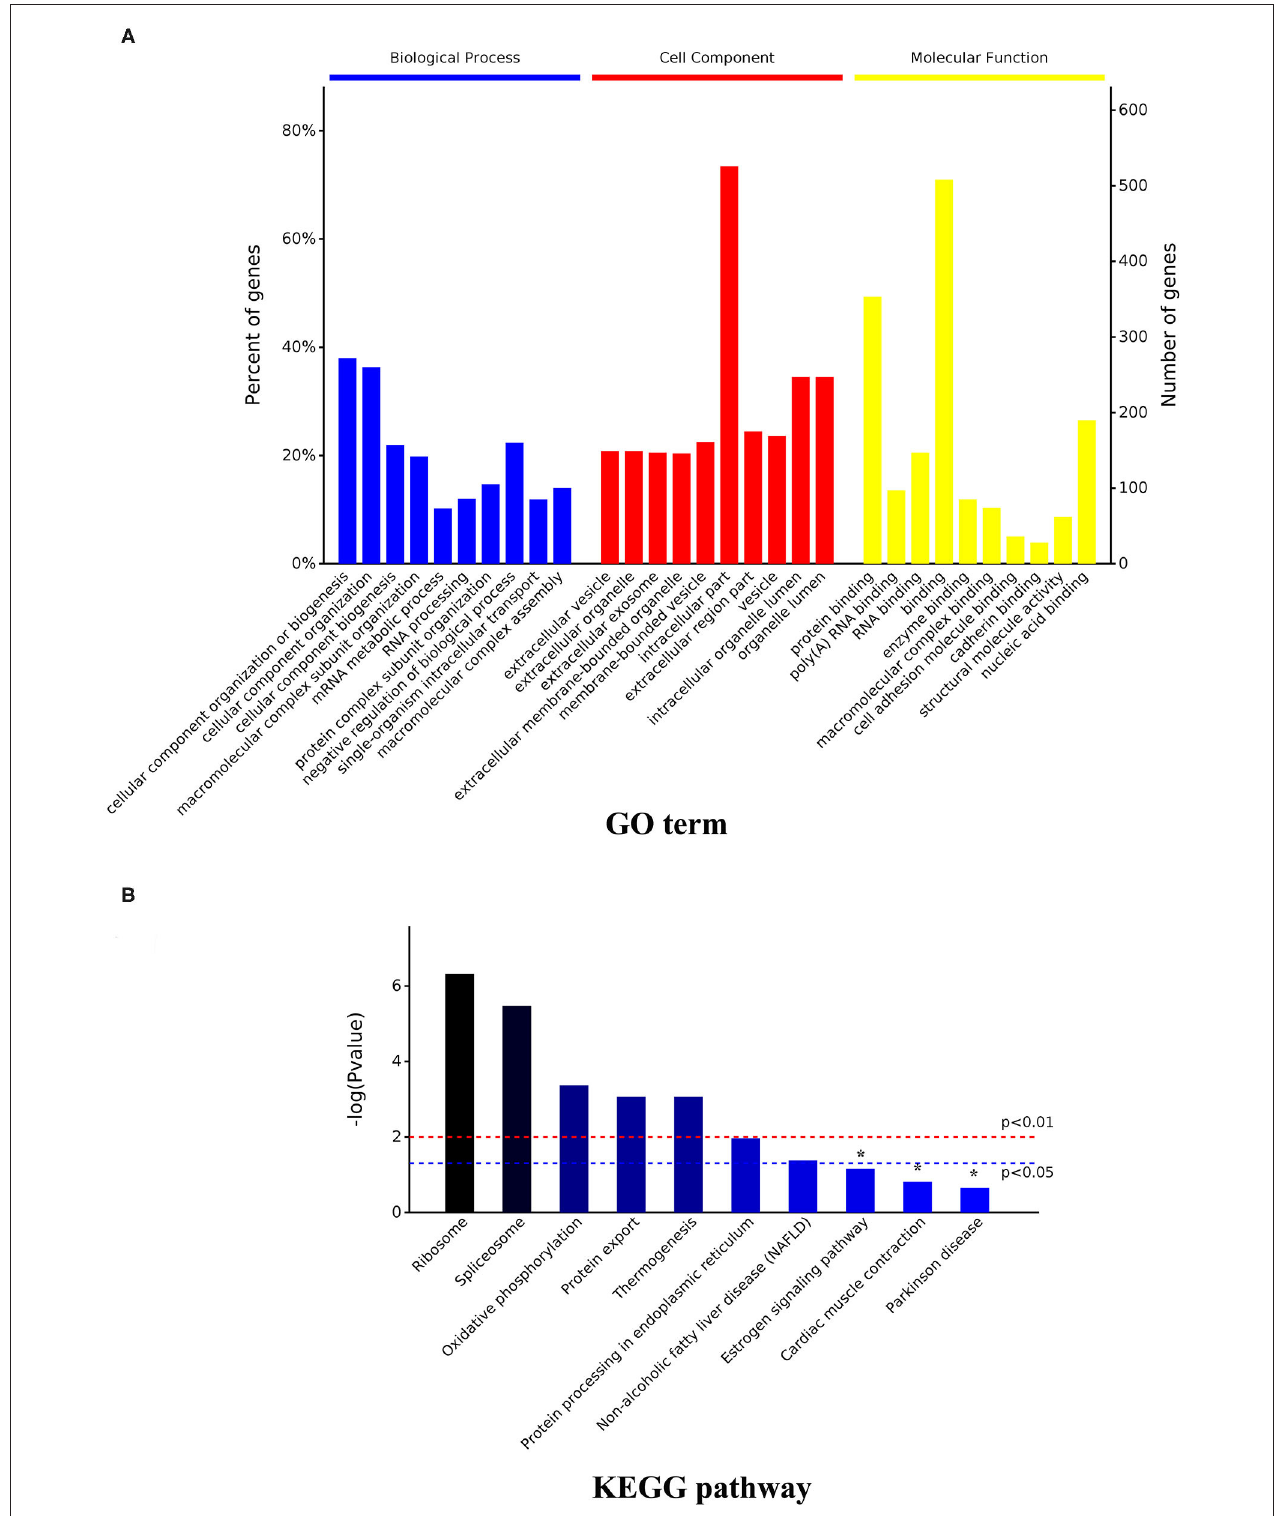
FIGURE 5 | GO and KEGG enrichment analysis of the total DAPs. (A) GO analysis result; (B) KEGG pathway analysis result. DAPs, differentially abundant proteins.